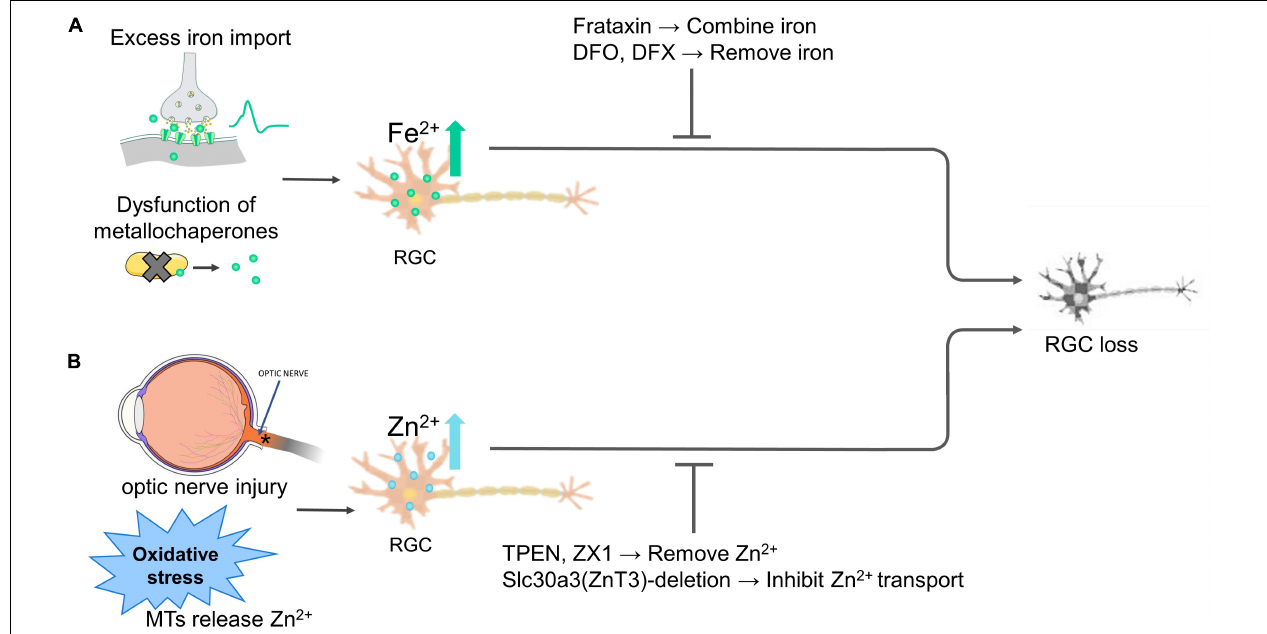
FIGURE 2 | Iron and zinc homeostasis regulate the fate of retinal ganglion cells (RGCs). (A) Overly extracellular iron import, iron-binding proteins dysfunction disturbs intracellular iron levels, both causes RGC death. Overexpressing frataxin or the use of iron-chelating agents deferoxamine (DFO) and deferasirox (DFX) to stabilize or remove the excessive Fe 2 + alleviates RGC death. (B) Optic nerve injury and various stimuli such as oxidative stress liberate Zn 2 + from MTs, inhibiting RGC survival and axon regeneration. Zinc transporter Slc30a3-deletion or the Zn 2 + chelator TPEN and ZX1 treatment inhibit transport or chelate Zn 2 + , protecting RGC survival and axon regeneration. Abbreviations: MTs,